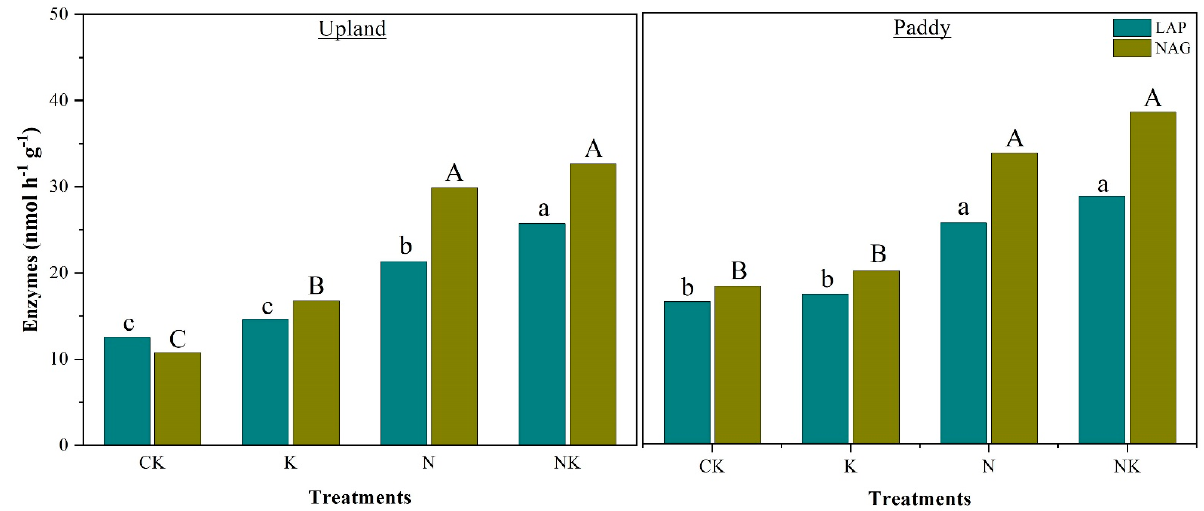
Figure 2. The effects of different fertilization treatments on the activities of extracellular enzymes in upland and paddy soils. Bars indicate the standard error, n = 3. Different letters indicate significantly different means at p < 0.05 using the least significance difference (LSD) test.